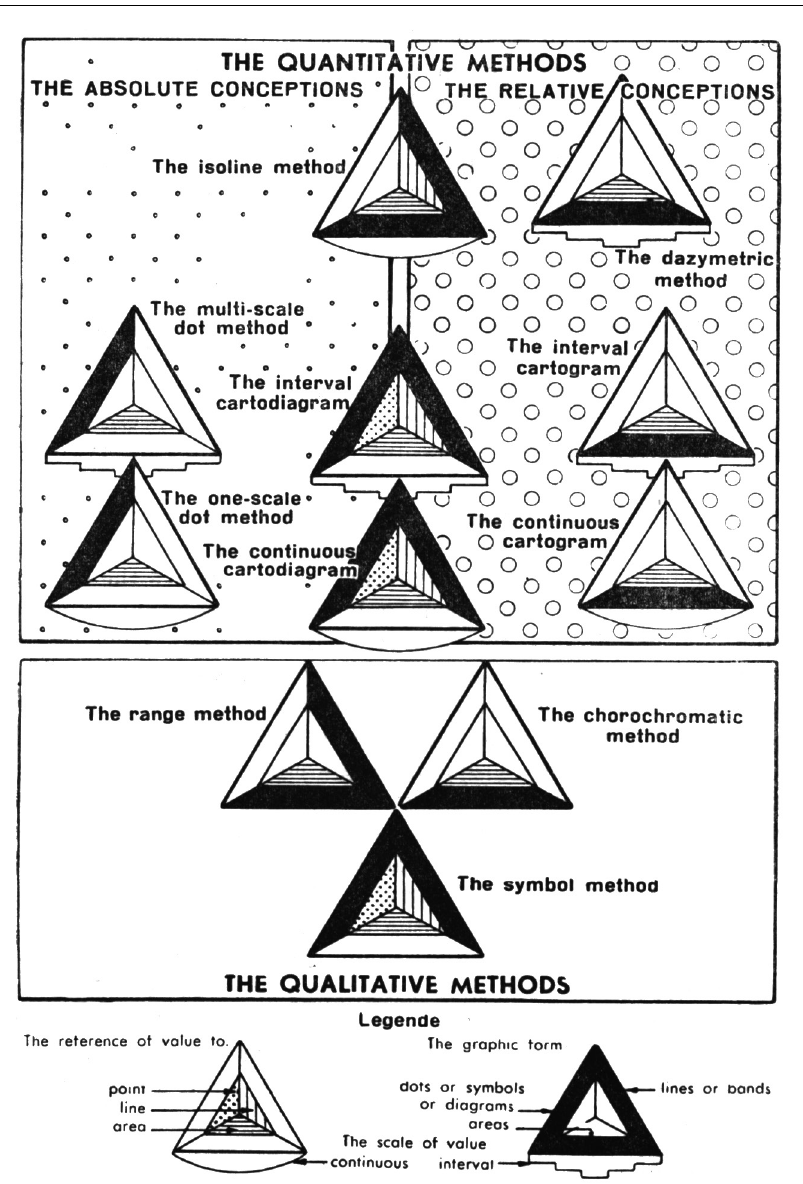
Fig. 1. Model of cartographic presentation methods (according to L. Ratajski